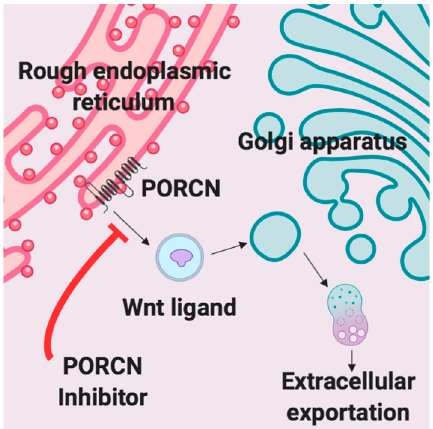
Figure 1. PORCN inhibition. Extracellular exportation of WNT ligand is prohibited due to a lack of a necessary lipid attachment to WNT by